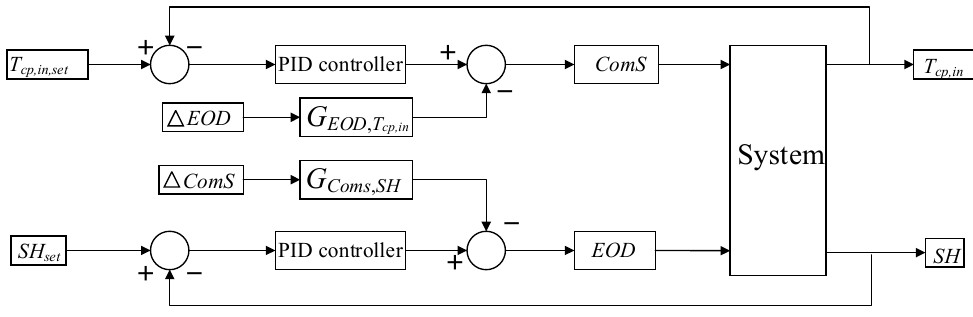
Figure 2. Coupled control strategy of SH and T cp,in.